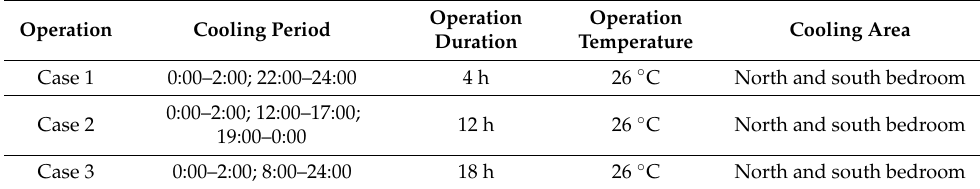
Table 3. The operation patterns of the air conditioners.